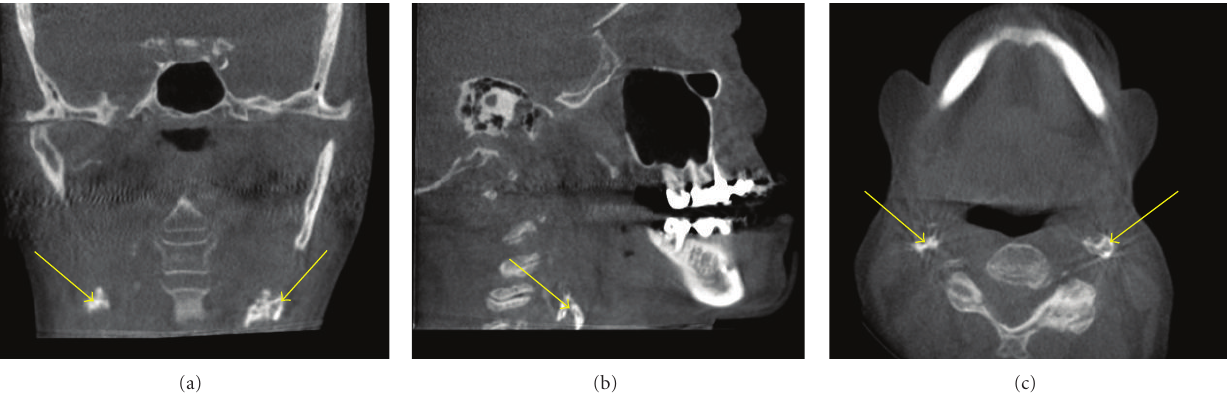
Figure 6: Carotid artery calcifications (arrows) seen as multiple small radiopaque linear entities taking the outline of the shape of a vessel in the cervical regions on these MPR images.